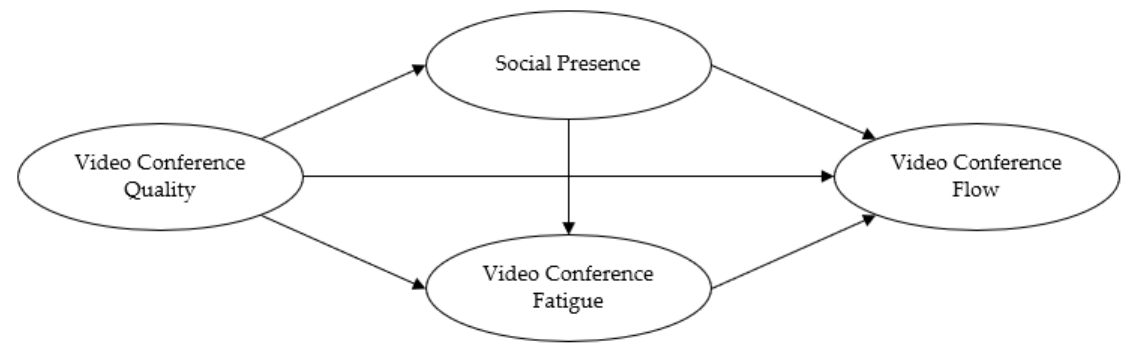
Figure 1. Theoretical Framework on the relationship between video conference quality and psychological factors of video conference participants of MICEs; social presence, fatigue, and flow.